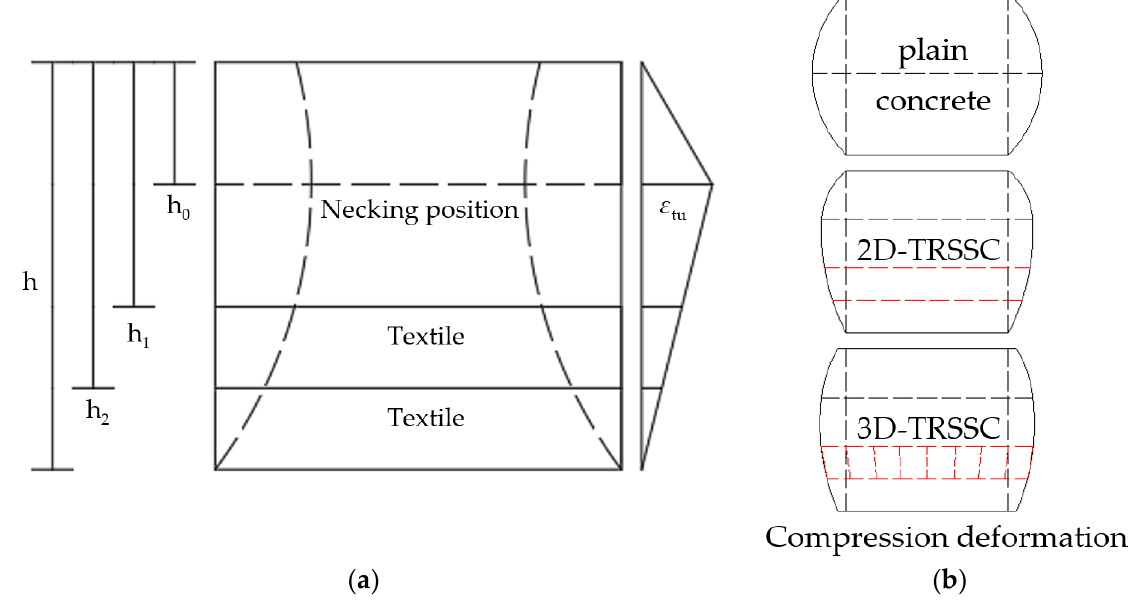
Figure 6. ( a ) Strain relations in compressive specimens; ( b ) the macroscopic deformation diagram of specimen under compression.